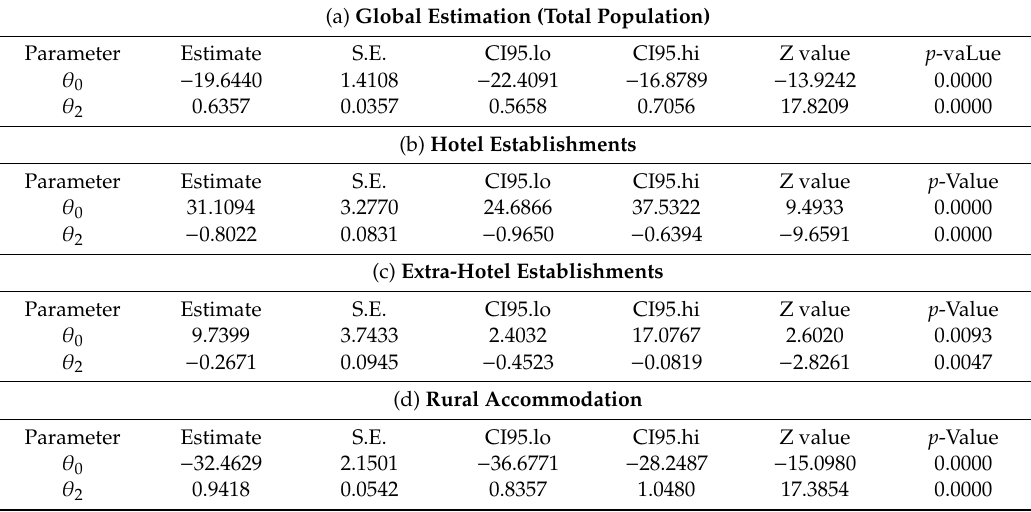
Table 4. Estimation of model (3) λ ( u ,x ) = exp ( θ 0 + θ 2 y ) . (a) Global Estimation (Total